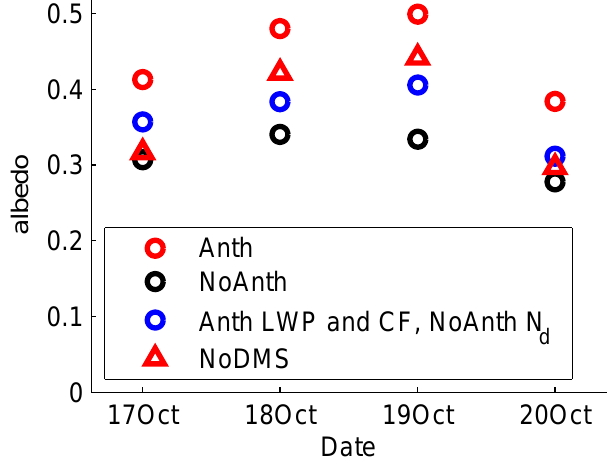
Fig. 11. Average albedo interpolated over Hook1 2-D trajecto- ries (same trajectories used in Fig. 8) and averaged over each day, weighted by solar insolation. The Anth (red circles), NoAnth (black), and NoDMS (red triangles) simulations are shown. The blue circles are albedo computed using Anth LWP and CF, and NoAnth N d and include a correction for biases caused by WRF- Chem’s binary CF (average of the Twomey effect estimates using Anth and NoAnth as the base simulations with constant LWP and CF). The Twomey effect estimate is thus the difference between red and blue circles, while secondary effects are represented by the dif- ference between blue and black